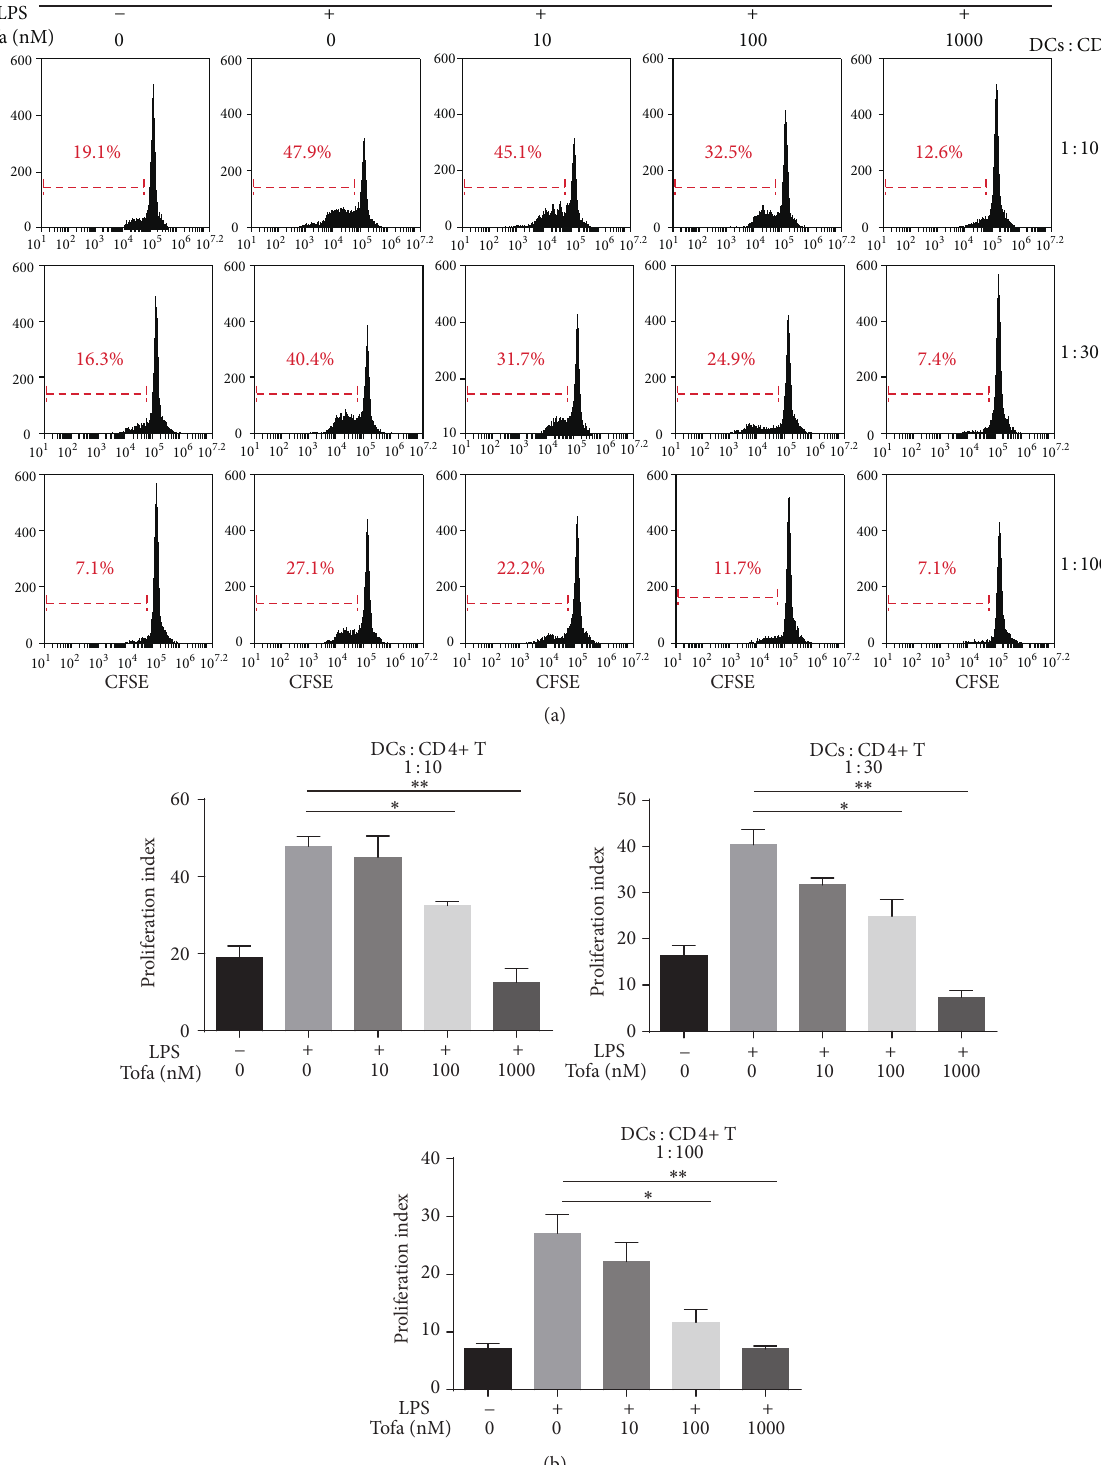
Figure 5: Antigen-specific T cell stimulation by MOG 35 pulsed-Tofa-DCs. (a) ImDC, mDCs, and Tofa-DCs were mixed with CFSE-labeled - 55 CD4+ T cells from EAE mice for 72 hours with different ratios of DCs: CD4+ T (1: 10, 1: 30, and 1: 100), and the proliferation of T cells was determined by CFSE dilution through flow cytometry. (b) Graphic shows the average ± SEM of the percentage of proliferating CFSE-T cells. The representative results of three independent experiments with similar findings are shown. Statistical testing was performed using the Mann-Whitney test. ∗ 𝑃 < 0.05 and ∗∗ 𝑃 < 0.01